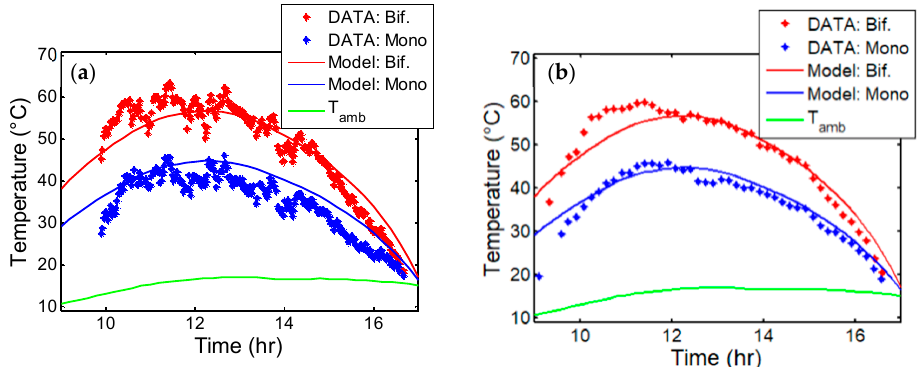
Figure 4. Data of a single day of module temperature compared with the values predicted by the model ( a ) and average values compared with the model ( b ). Ambient temperature is also reported as reference.